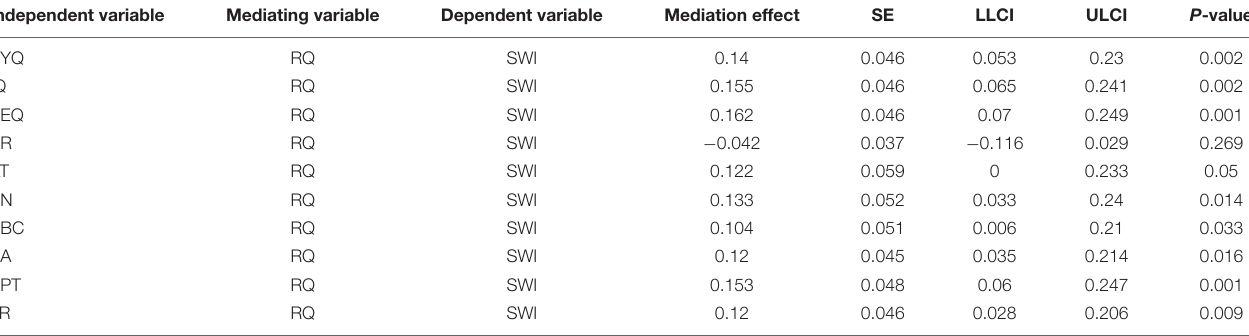
TABLE 5 | Mediating effect